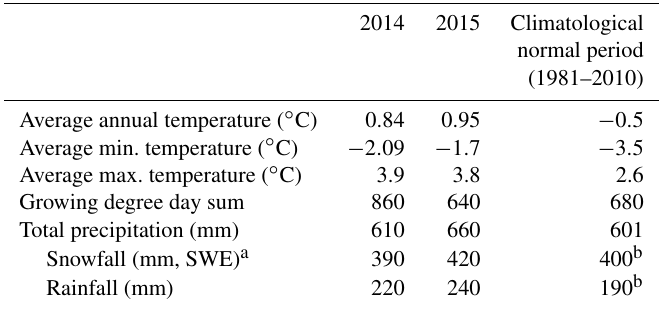
Table A1. Meteorological parameters from Värriö. Values for the climatological normal period are from Pirinen et al. (2012). Grow- ing degree day sum was calculated as the average daily tempera- ture (average of daily maximum and minimum temperatures) above the 5 ◦ C base temperature, accumulated on a daily basis over the year. Negative values are treated as 0 and ignored. SWE stands for snow water equivalent. a Data from SMEAR 1 Station. b Data from SMEAR 1 Station (only 2009–2015). All other data are collected from the Värriö Subarctic Research Station by the Finnish Meteo- rological